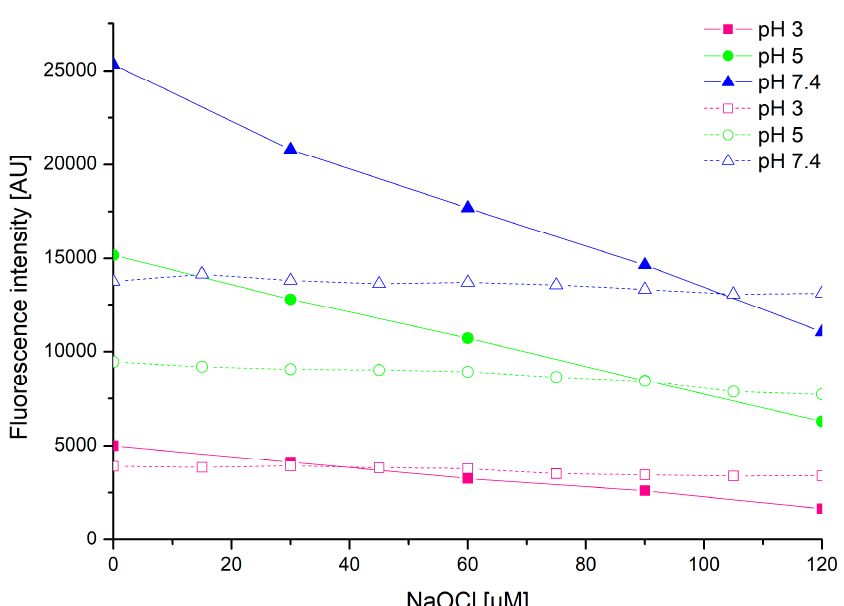
Figure 5. Comparison of sodium hypochlorite-induced changes in the fluorescence intensity of 2 (150 μ M) (permanent lines), with that recorded upon the addition of Trolox (40 μ M) (dashed lines). The measurements were carried out at λ Ex 289 nm, λ Em 460 nm, and at a temperature of 25 °C.